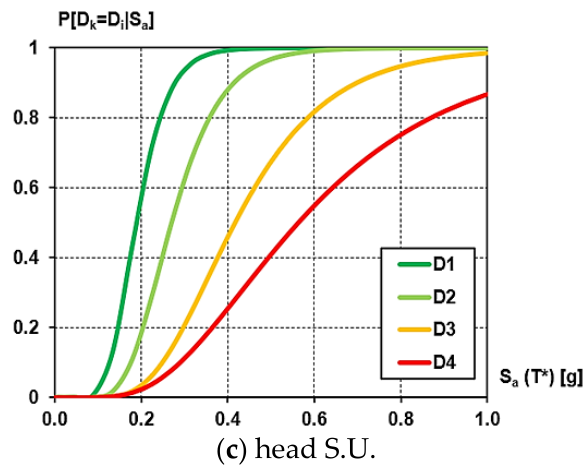
( c ) head S.U. Figure 16. Fragility curves for the whole aggregate ( a ), intermediate S.U. ( b ), and head S.U. ( c ) after floor stiffening intervention considering the most unfavourable pushover case in each analysis direction. Similarly, Table 6 suggests the values of the median and standard deviation for the deriva- tion of the typological fragility functions associated with consolidated structural systems. Table 6. Median and dispersion values for the examined typological fragility functions in the case of floor stiffening intervention. Struct. Configuration Aggregate